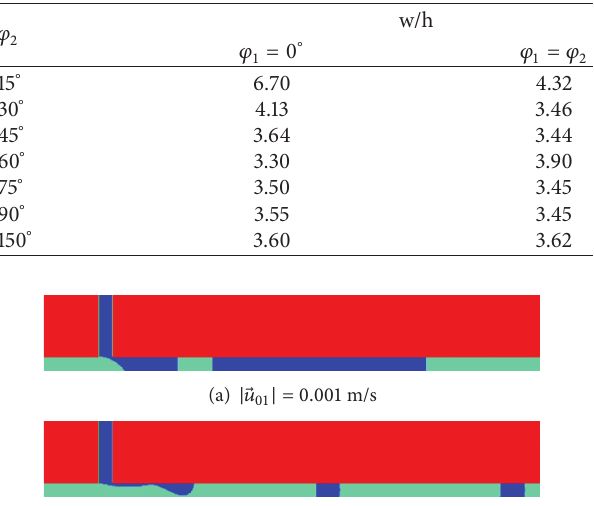
Figure 4: Simulated segment flow mode in a Y-shaped microchan- nel at various inclined angles 𝜑 1 and 𝜑 2 .